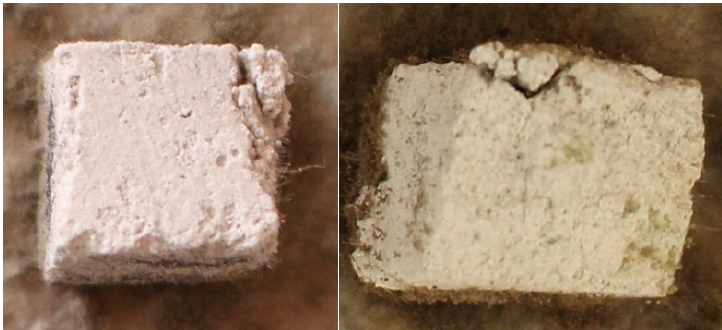
Figure 4. Sample 2 after 25 (left) and 41 (right) days.